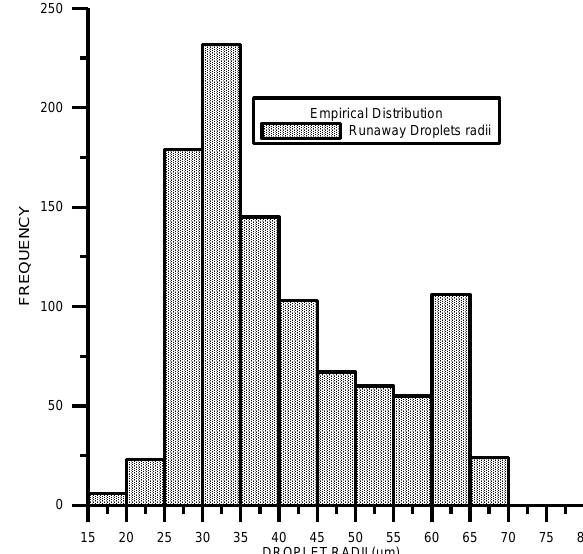
Fig.10. Empirical distribution for the radius of the runaway droplets. The results were generated Fig. 10. Empirical distribution for the radius of the runaway from 1000 realizations of the Monte Carlo algorithm. droplets. The results were generated from 1000 realizations of the Monte Carlo